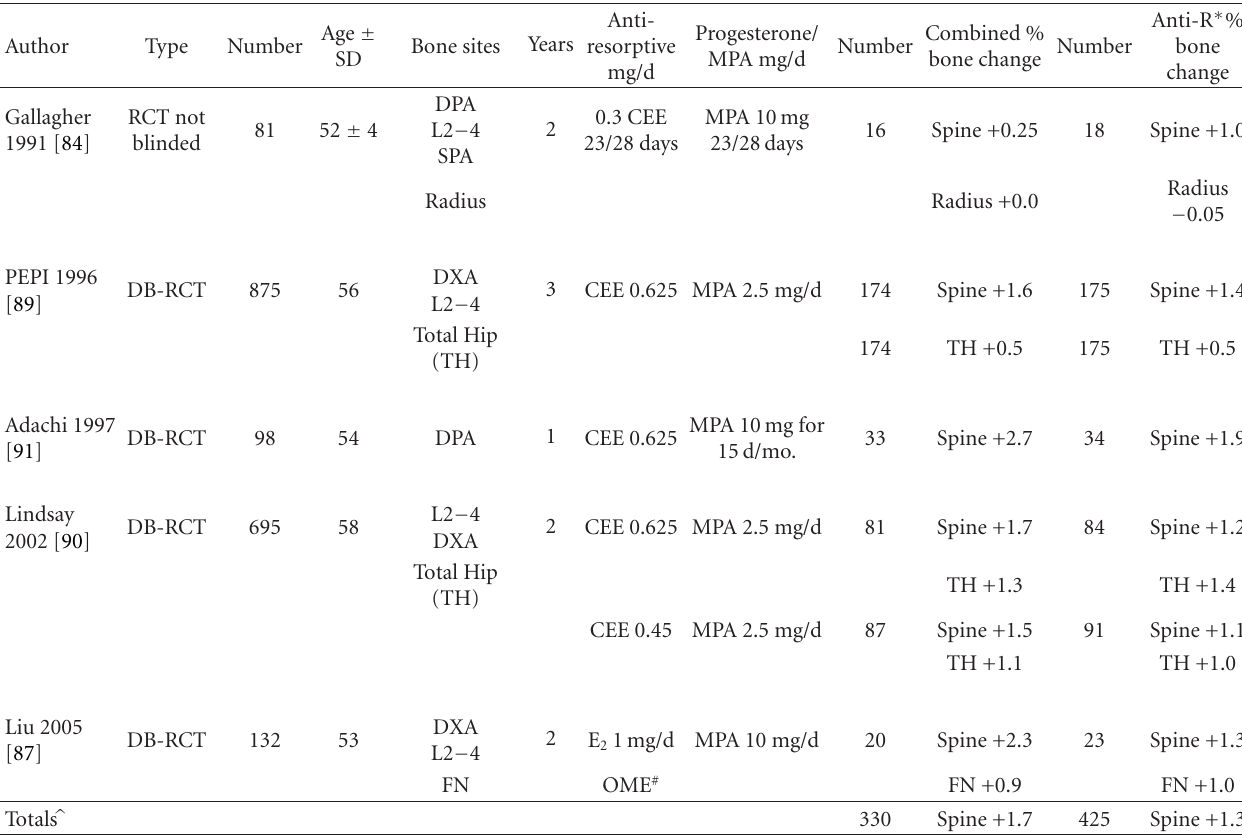
Table 4: Comparison of randomized double-blind controlled trials of bone change in postmenopausal women with osteoporosis comparing combined estrogen [Conjugated Equine Estrogen (CEE) or Estradiol (E 2 )] plus progesterone or medroxyprogesterone (MPA) and documenting percentage (%) change per year in Bone Mineral